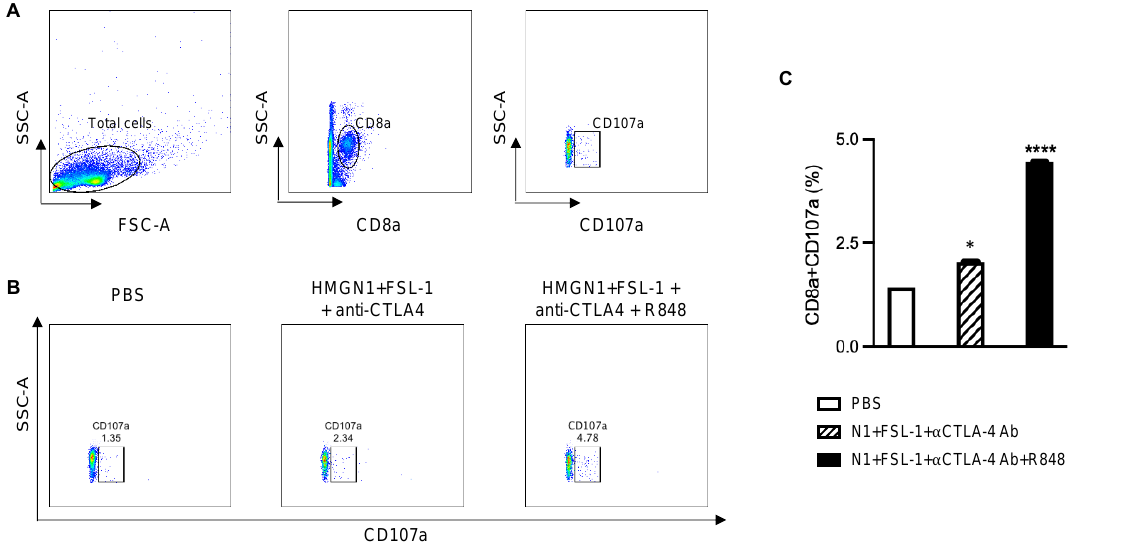
Figure 6. Treatment with the combination of N1, FSL-1, R848, and α CTLA4 antibody elevated the generation of 4T1-specific CTLs. ( A ) Flow cytometry gating strategy. ( B ) Representative plot of an individual mouse dLN. ( C ) The average (mean ± SEM, n = 5) levels of tumor-specific CTLs (CD107a+ CD8a+ T cells) in mouse tumor dLNs. * p < 0.05; and **** p < 0.0001.